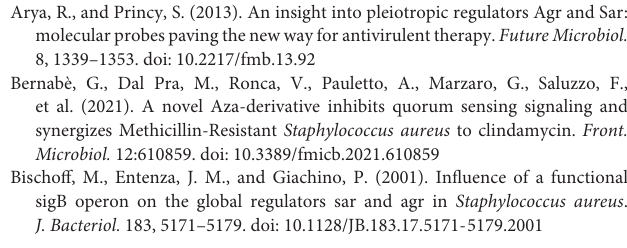
Supplementary Figure 3 | Effects of agr alleles on agr transcriptions. The total bacterial RNA was isolated in mid-log phase, and gene transcription was appraised with quantitative RT-PCR. The transcription of agrA (A–C) and RNAIII (D–F) among the four wild agr allele strains ( agr I/Newman, agr II/N315, agr III/MW2, and agr IV/XQ) (left) and agr plasmid complemented congenic strains in Newman (middle) or N315 (right) background were analyzed. Error bars represent the average standard deviation (SD) of three separate experiments. Supplementary Figure 4 | Effects of agr alleles on virulence gene transcriptions of S. aureus . The total bacterial RNA was isolated in mid-log phase, and gene transcription was appraised with quantitative RT-PCR. The transcription of hlgB (A–C) , hld (D–F) , psm α (G–I) , and psm β (J–L) among the four wild agr